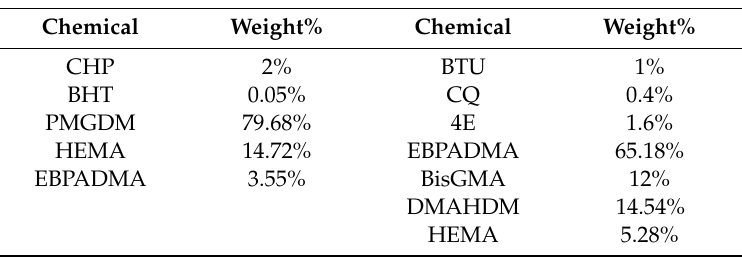
Table 4. Chemical composition of PEHB monomers with 4% DMAHDM.